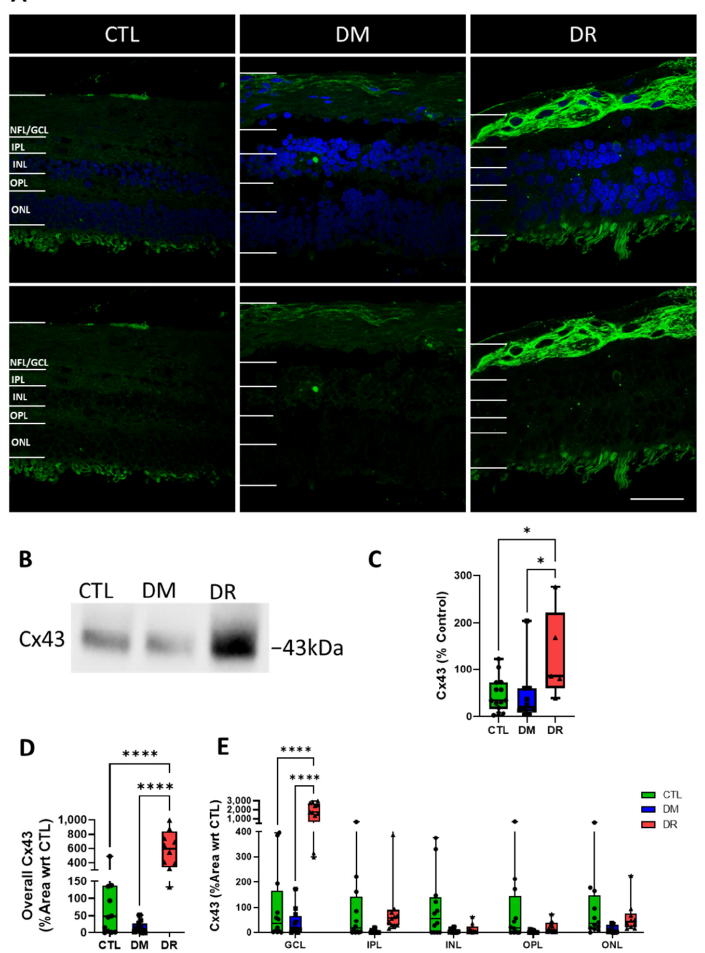
Figure 4. Cx43 expression increased significantly in the NFL/GCL in DR. ( A ) Immunohistochemistry labelling of Cx43 (green) showed low Cx43 expression in CTL and DM while a significant increase was found in DR, specifically in the NFL/GCL. ( B ) Western blotting analysis also showed low Cx43 levels in CTL and DM but high expression in DR . ( C ) Western blotting quantification showed lower Cx43 expression in DM compared to CTL but without significant difference ( p = 0.9945), while significantly more Cx43 was expressed in DR compared to CTL ( p ≤ 0.05) and DM ( p ≤ 0.05). ( D ) A similar trend was found with Cx43 levels in the entire retina with slightly lower expression in DM compared to CTL but without significant difference ( p = 0.8591) and significantly higher expression in DR compared to CTL ( p ≤ 0.0001) and DM ( p ≤ 0.0001). ( E ) Quantification of Cx43 expressed in each retinal layer highlighted significantly higher Cx43 levels in DR compared to CTL ( p ≤ 0.0001) and DM ( p ≤ 0.0001) but only in the GCL, while low expression levels were found in other retinal layers in all groups. Scale bar = 50 µm. Statistical analysis was carried out using one-way ANOVA for overall expression in the entire retina and two-way ANOVA for expression in each retinal layer. * p ≤ 0.05; **** p ≤ 0.0001. Data point of each patient in CTL, DM and DR are marked as circle, square and triangle, respectively.